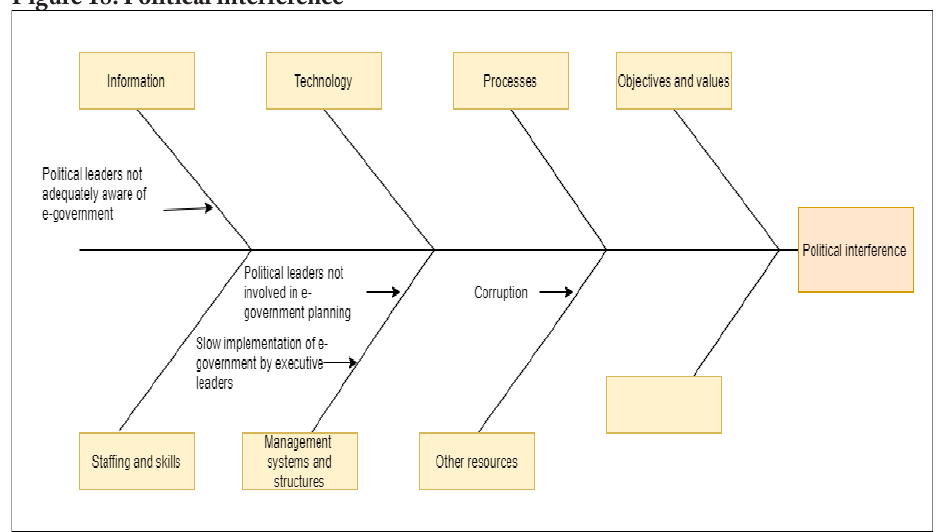
Figure 18: Political interference